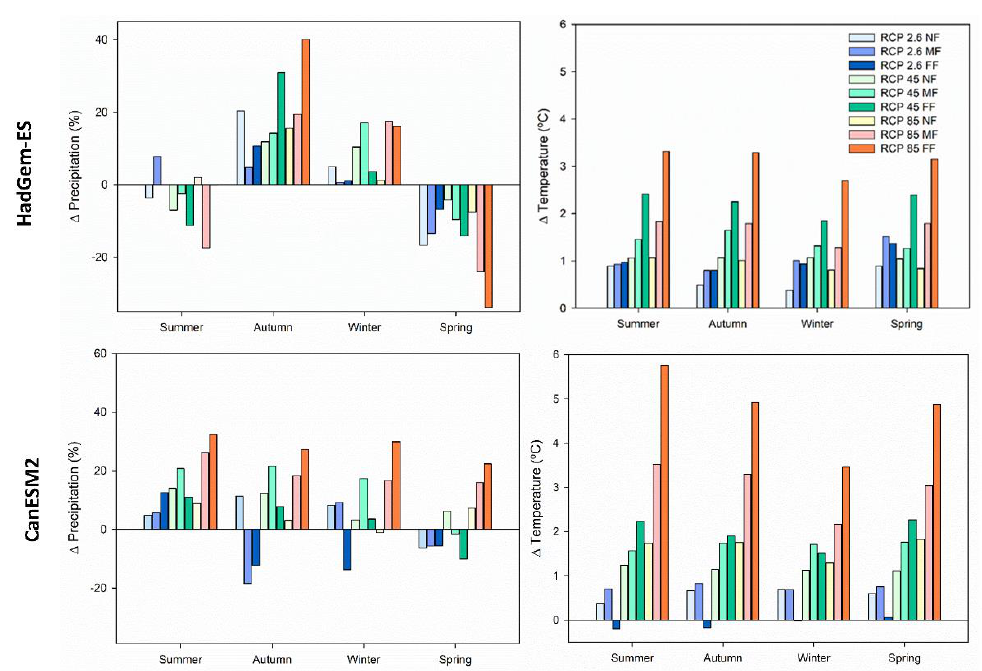
Figure 4. Local climate change impact analysis variation in precipitation (left) and temperature (right) for CanESM2 (upper panels) and HadGem2-ES model, (lower panels) from baseline (1981– 2005). Summer refers to January, February and March, Autumn refers to April, May and June, Winter refers to July, August and September and Spring refers to October, November and December.